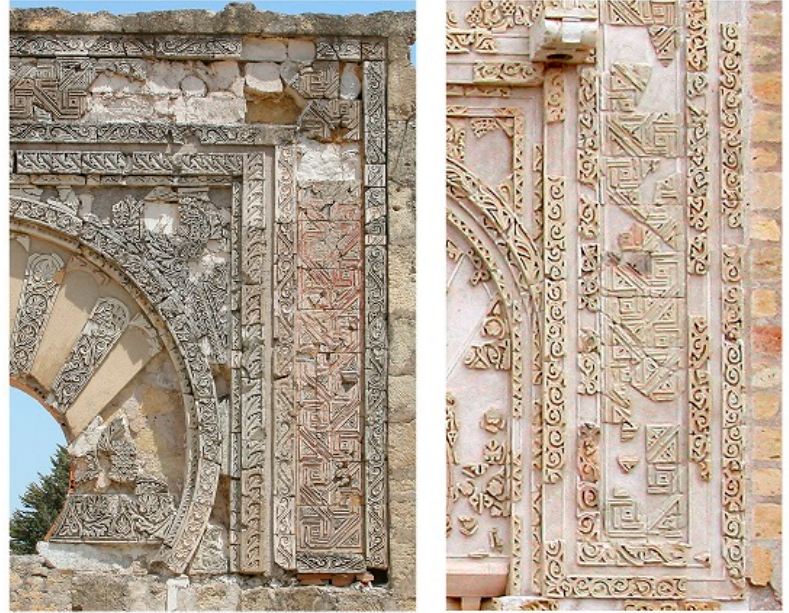
Figure 11. House of the Pool ( left ) and House of Ja c far ( right ). Frames with geometric decoration. (© Conjunto Arqueológico de Madinat al-Zahra). Conjunto Arqueol ó gico de Madinat